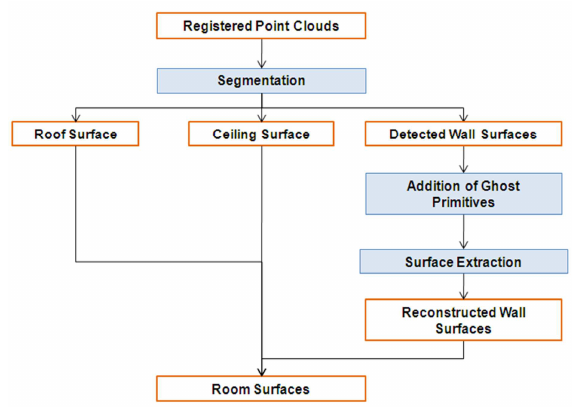
Figure 2. Pipeline for ground plan contour detection.